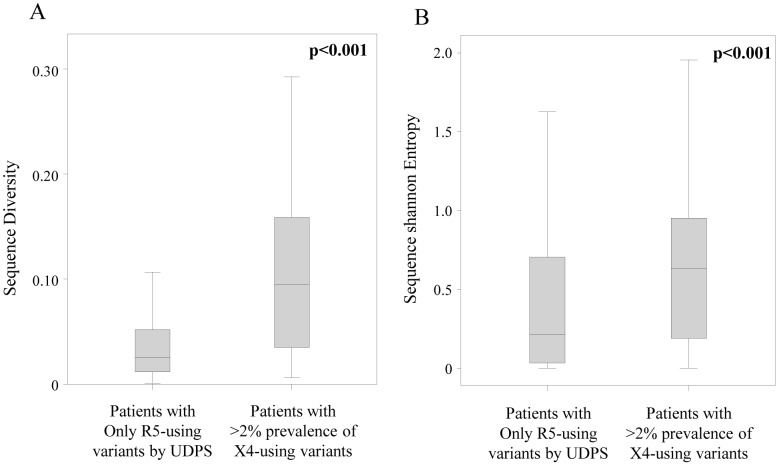
Quasispecies heterogeneity.The box plots represent the diversity of amino acid sequences (A), and Shannon entropy (B) among patients with X4 species detected by UDPS at a prevalence lower or higher than 1%. P-values were calculated by Mann-Whitney Test.